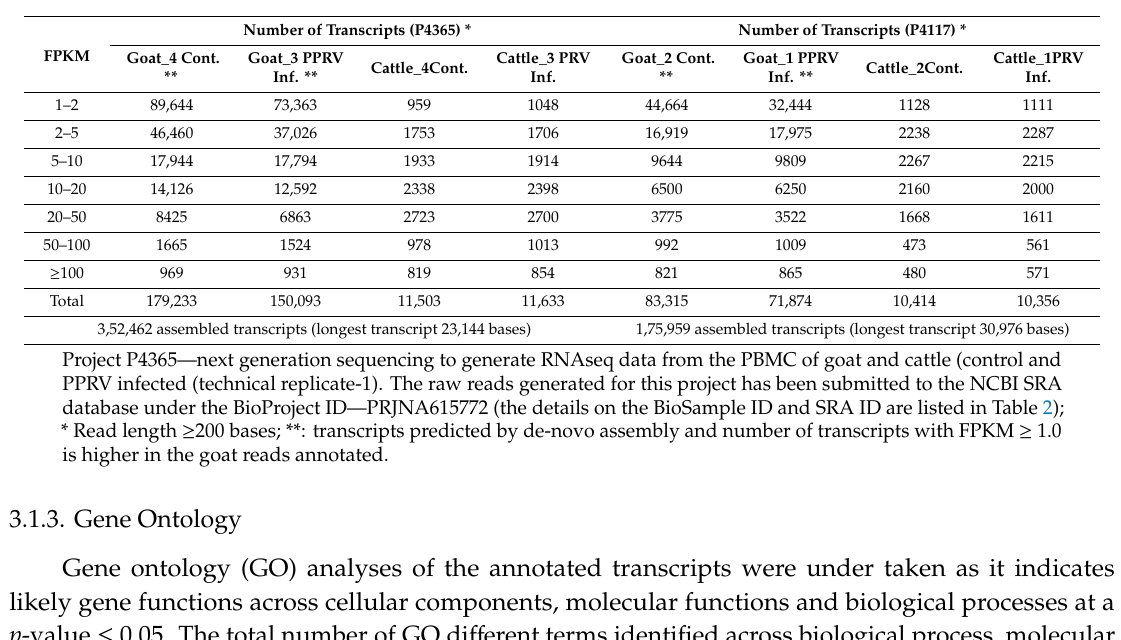
Table 3. Transcript expression and total number of transcripts identified in the next generation sequencing experiments across goat and cattle PBMC infected with